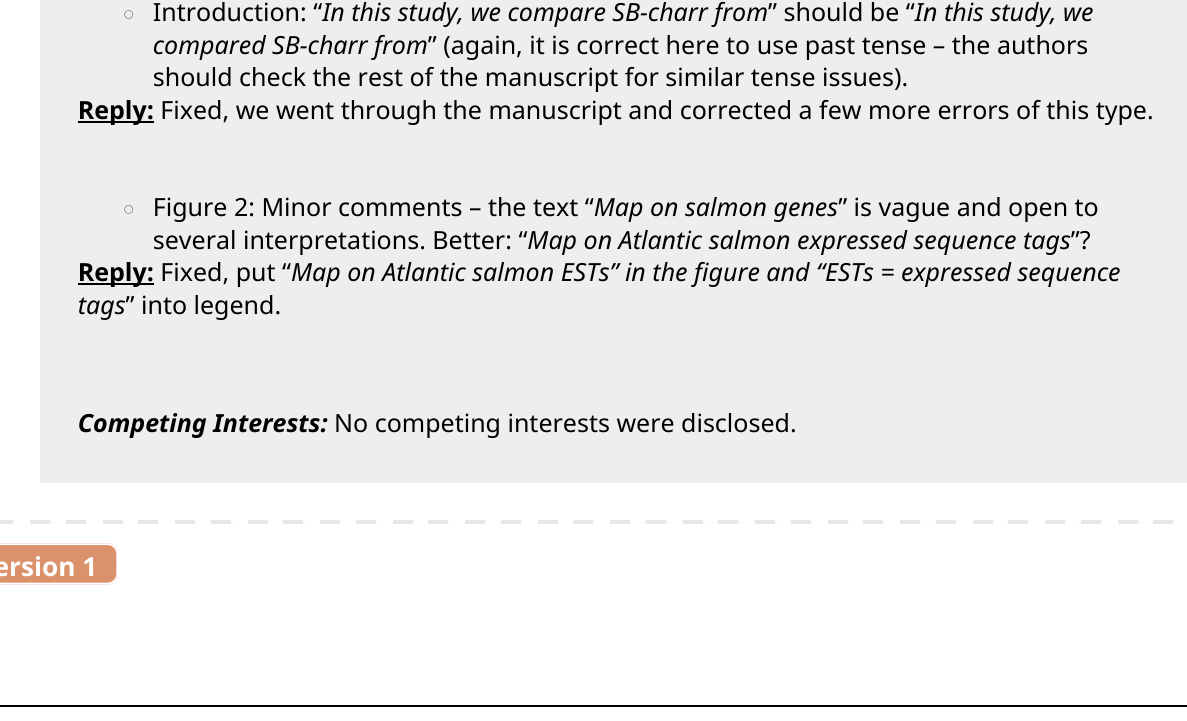
Figure 1: It would be easier for the reader to link the text and images if the authors updated with ‘a’, ‘b’, ‘c’ and ‘d’ panels for each of the different charr morphs.